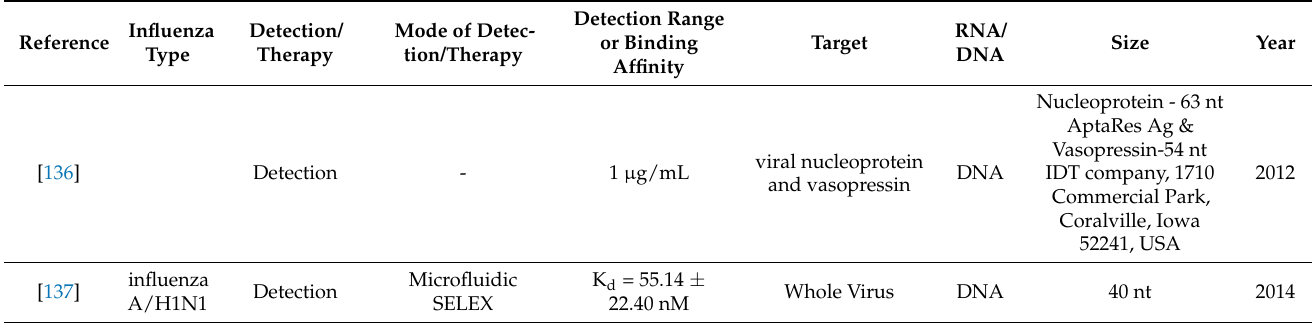
Table A3. List of aptamers and their properties for treatment and detection of influenza virus